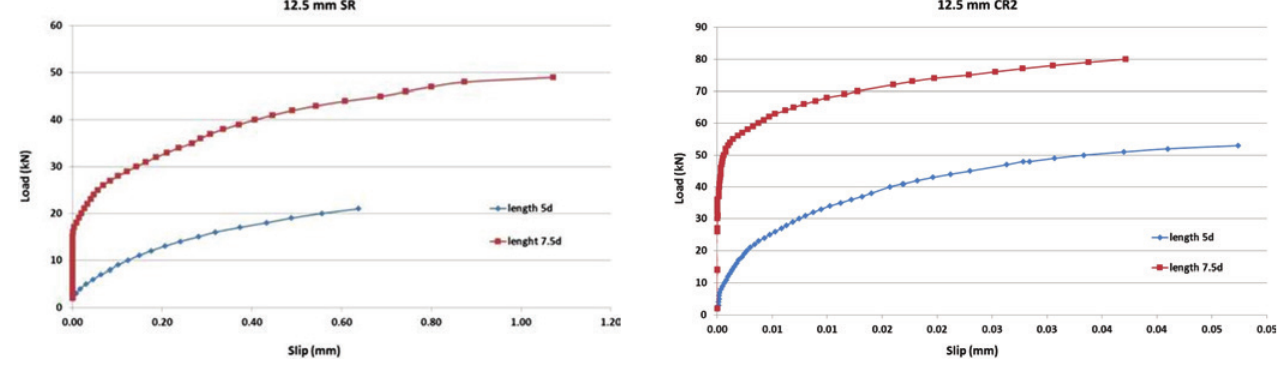
Figure 13 Influence of the embedded length, models: 12.5-5-2 and 12.5-7.5-2